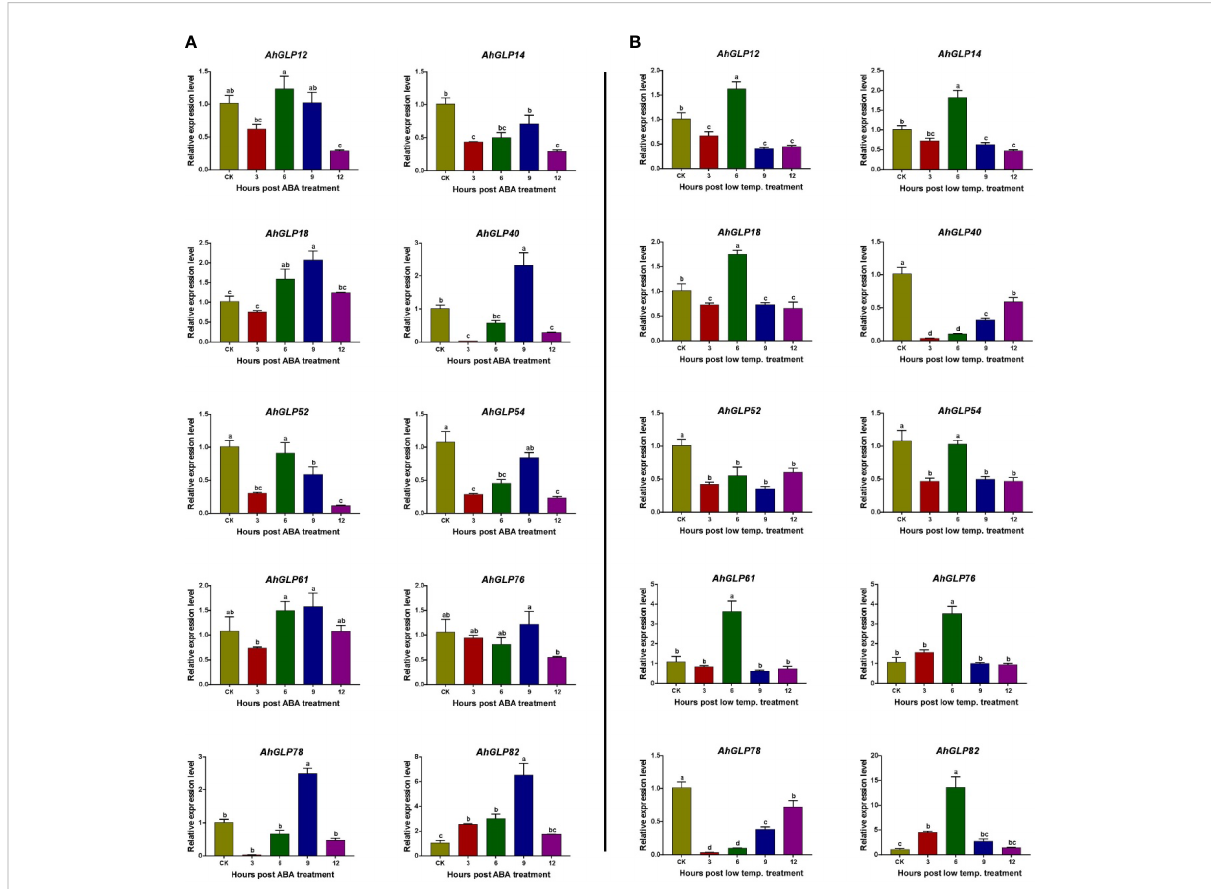
FIGURE 14 qRT-PCR-based expression pro fi ling of 10 selected genes under (A) abscisic acid and (B) low-temperature stress. CK represents the control samples, while 3, 6, 9, and 12 represent the hours after stress (ABA/low temperature) treatment. Data were analyzed by 2 - DD CT method and statistical signi fi cance was determined by ANOVA. a, b, and c represents the signi fi cance levels among expression at different time